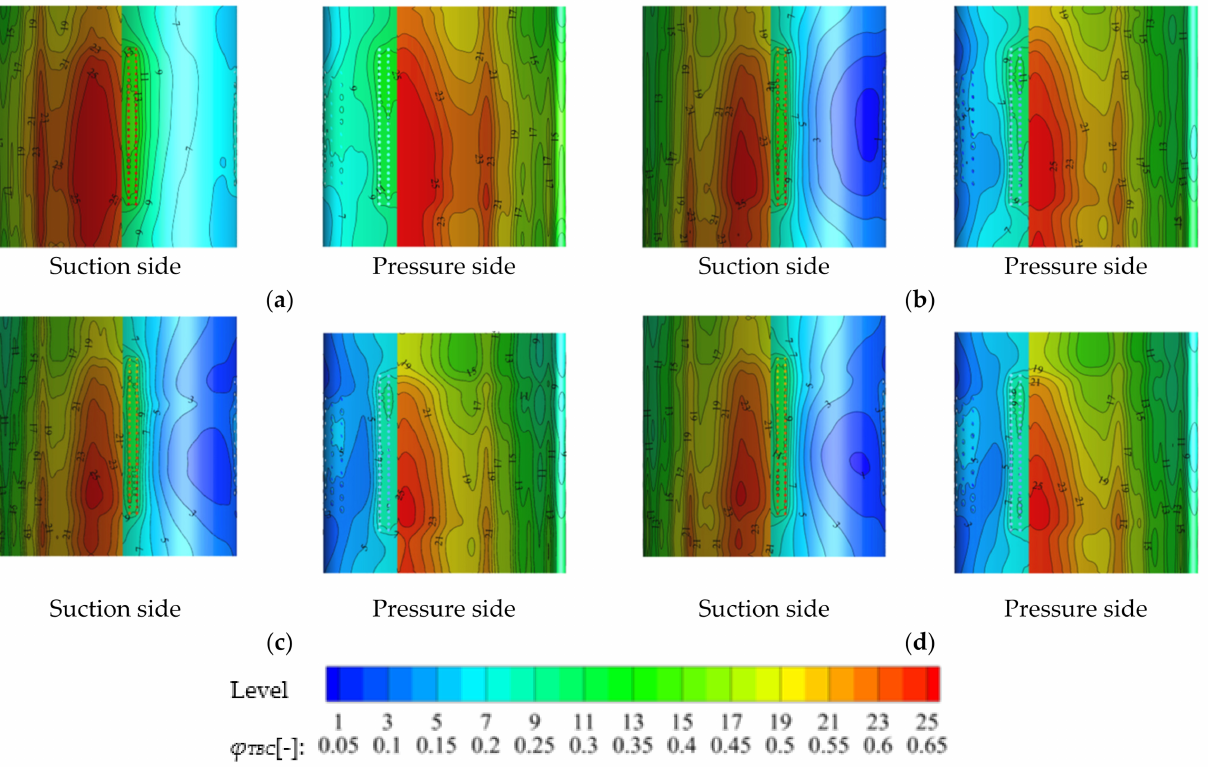
Figure 17. Overall cooling effectiveness distribution of coated vane for different cases. ( a ) Case 5: uniform inlet; ( b ) Case 6: HS only; ( c ) Case 7: HS and positive swirl; ( d ) Case 8: HS and negative